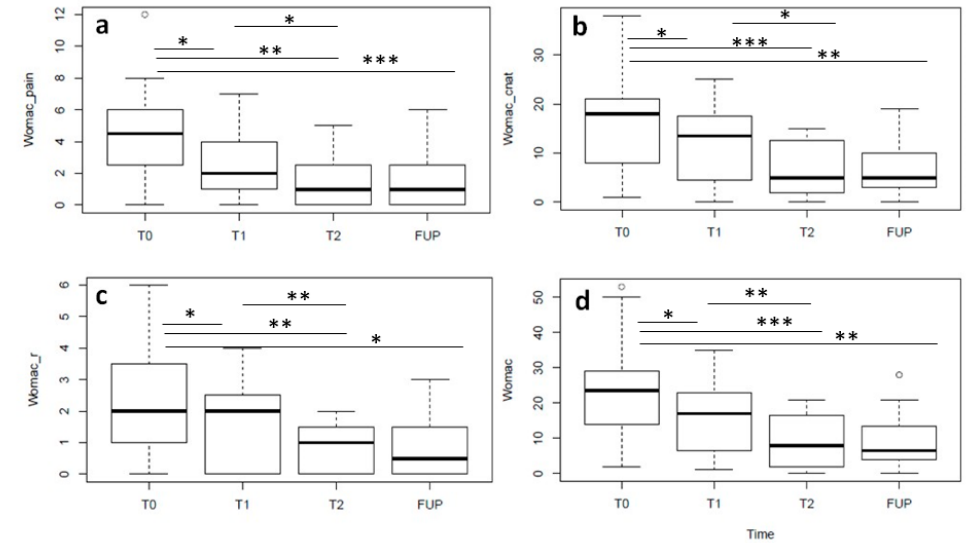
Figure 6. WOMAC pain ( a ), stiffness ( b ), physical function ( c ) sub scores and total WOMAC score ( d ). For all scores, median values at T1 are significantly lower than those at baseline (T1 vs baseline: pain, p = 0.03; stiffness, p = 0.04; physical function, p = 0.04; total score, p = 0.03), and median values at T2 are significantly lower than those at T1 (T2 vs T1: pain, p = 0.03; stiffness, p = 0.04; physical function, p = 0.001; total score, p < 0.001). For all scores, median values at the 6-month follow-up were not significantly different than that at T2 and were stable at the 6-month follow-up.